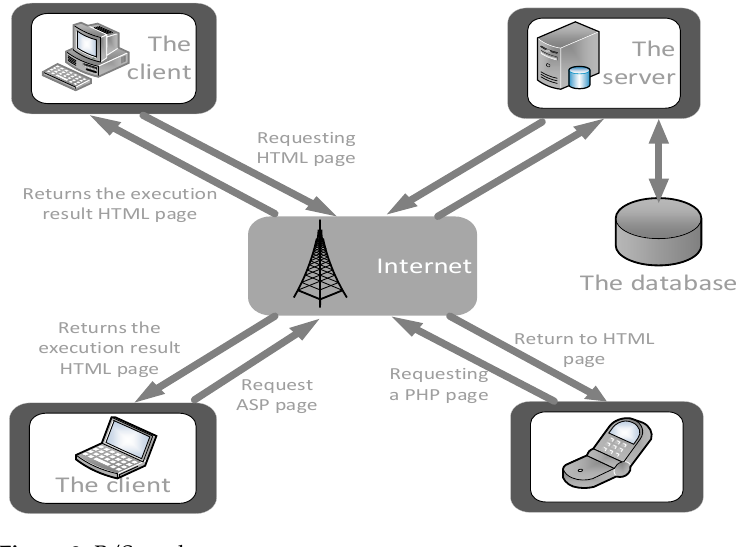
Figure 3. B/S mode .